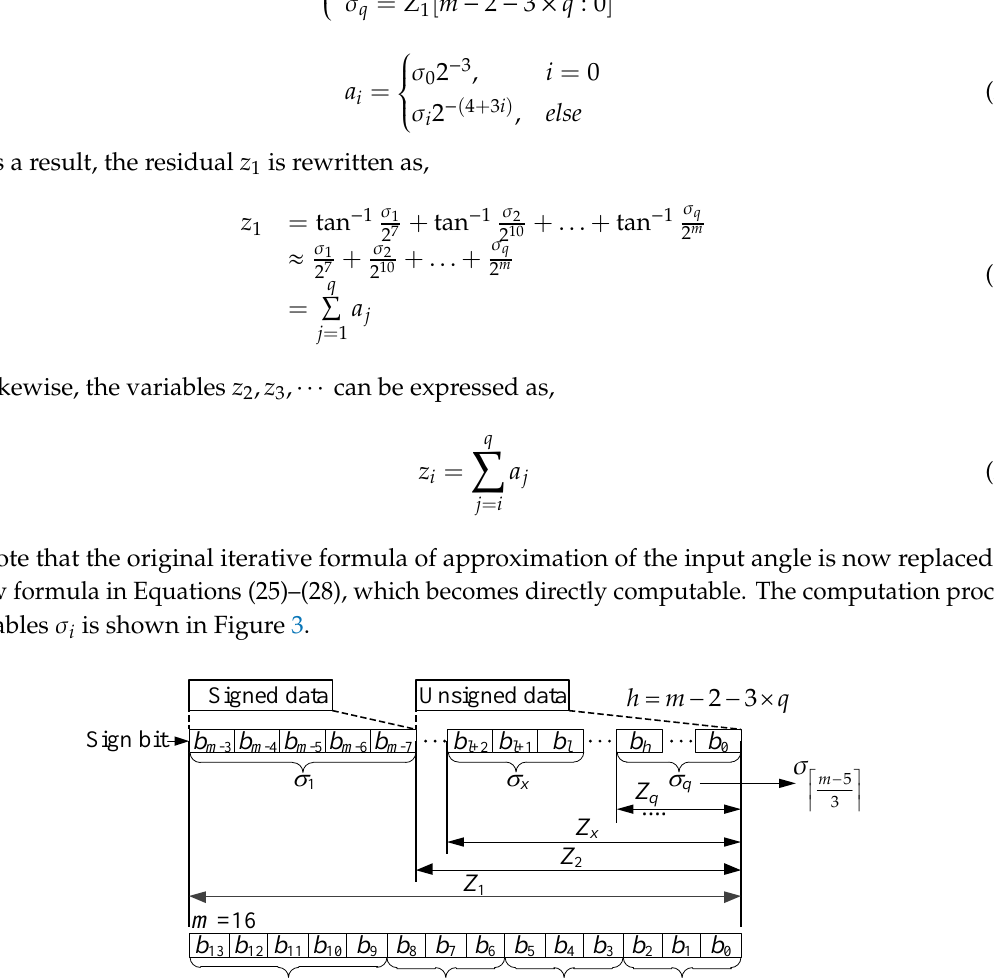
× 2 m (cid:99) = (cid:98) z i